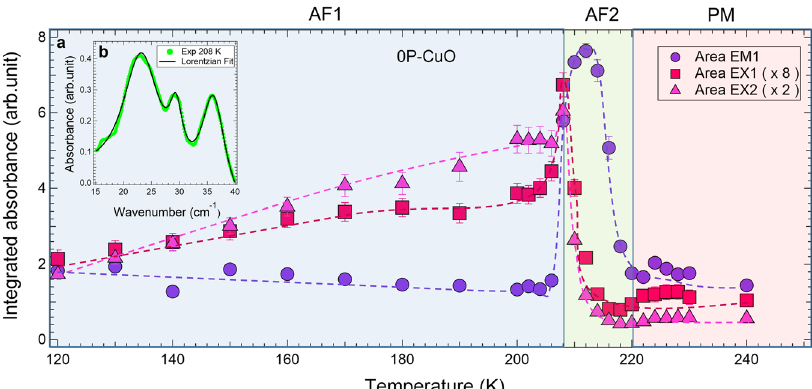
Fig. 2 Temperature dependence of the integrated electromagnon absorbance. a Integrated absorbance of the three excitations EM, EX1 and EX2 obtained from fi tting the absorbance spectra of the 0P-CuO sample outside DAC, and as a function of temperature with E ω ∥ [101]. The absolute values of the integrated absorbance of EX1 and EX2 were arbitrary multiplied by 8 and 2, respectively, in order to appear in the same scale as the values of the integrated absorbance of EM. b Example of Lorentzian fi t on the spectrum at 208 K from Fig. 1a. For each point, error bar obtained from the fi tting procedure is represented and visible if bigger than the